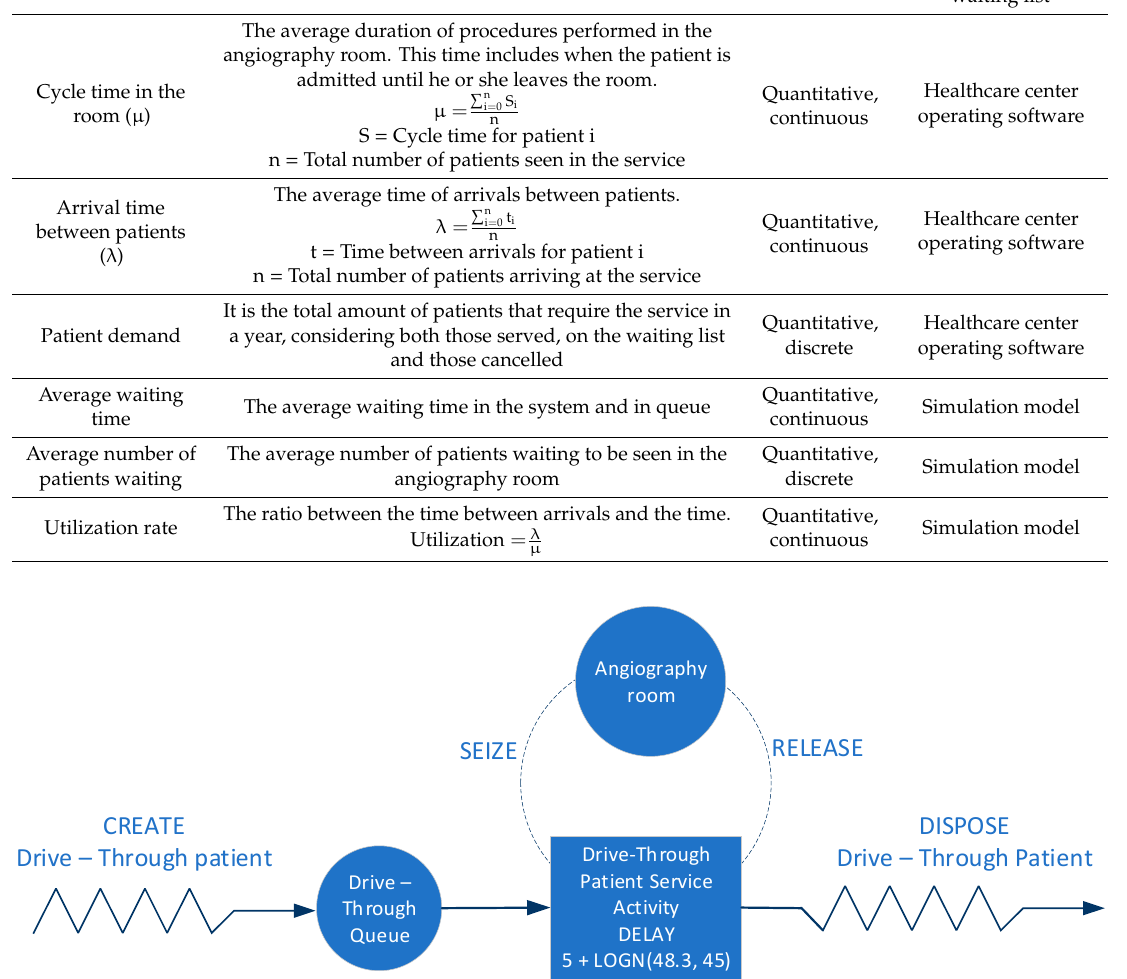
Figure 3. States transition diagram for the model DES. The scope of the project is delimited in knowing if the current resources are sufficient to meet the patient’s demand for the service. That is why, when the angiography room is mentioned, reference is made to the human resource (specialist doctors, technicians, nurses), angiography equipment and infrastructure.